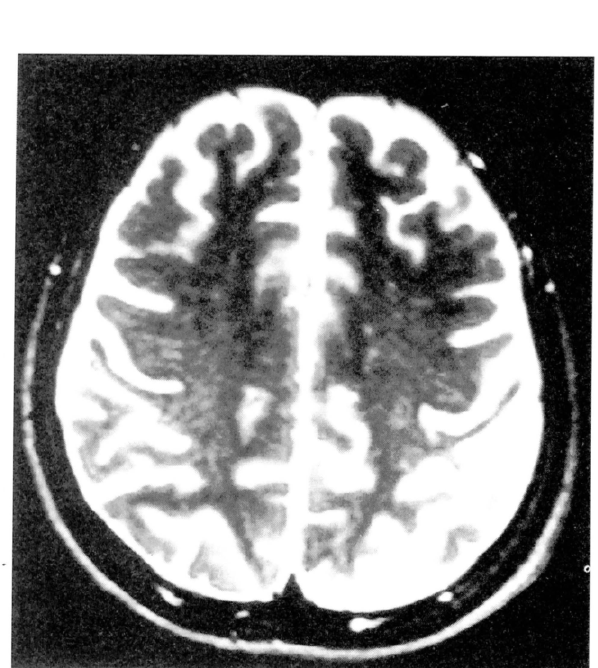
FIG. 1. Magnetic resonance images (1 .5 Tesla superconduct ing system, spin-echo method, T2 weighted images, TR = 3000 ms, TE = 120 ms) taken January 1992 showing mild atrophy in the parietal